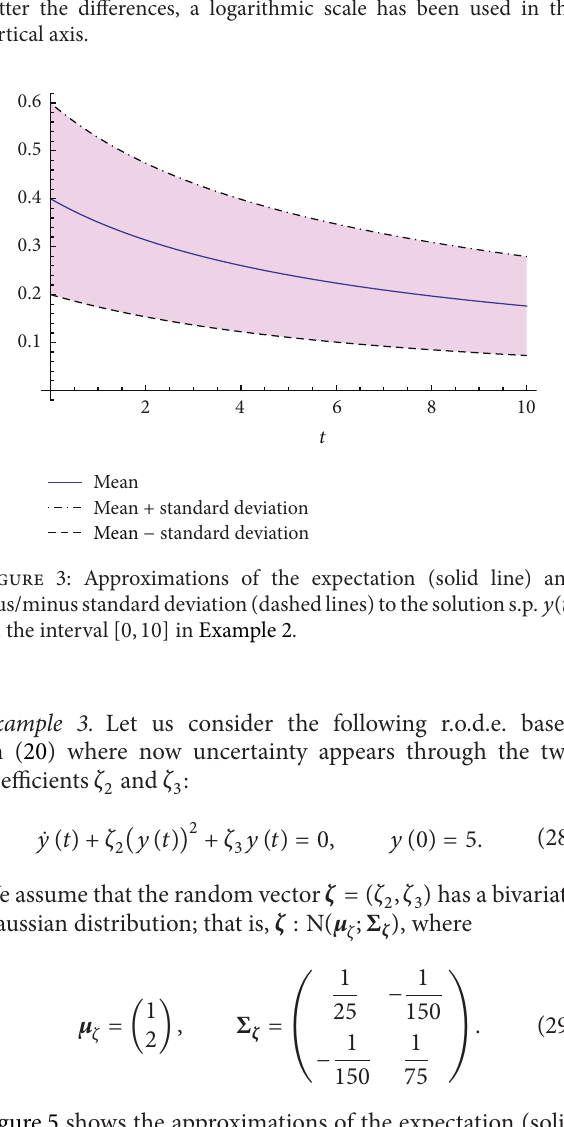
Figure 1: Relative errors of the approximations to the expectation of the solution s.p. 𝑦(𝑡) on the interval [0,7] in Example 1 by the proposed method and Monte-Carlo simulations. To highlight better the differences, a logarithmic scale has been used in the vertical axis.